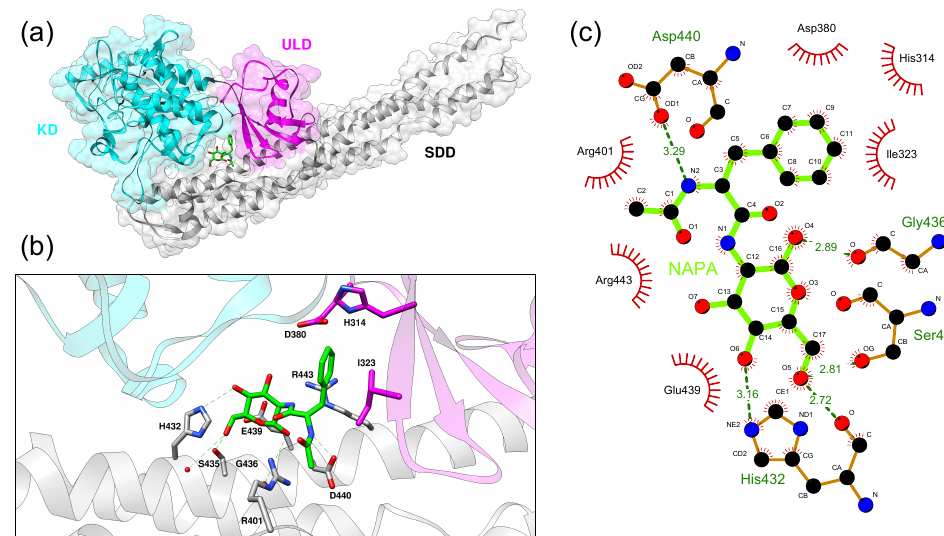
Figure 5. IKK α -NAPA complex top-ranked pose of the focused molecular docking experiment. ( a ) IKK α is depicted as cartoon. NAPA molecule is represented in stick model (green). KD, ULD and SDD domains are colored in cyan, magenta and gray respectively. ( b ) Interacting residues are represented in stick model. Dashed red lines indicate hydrogen bonds. ( c ) IKK α -NAPA non-covalent interactions. Dashed green lines indicate hydrogen bonds, red lines indicate hydrophobic